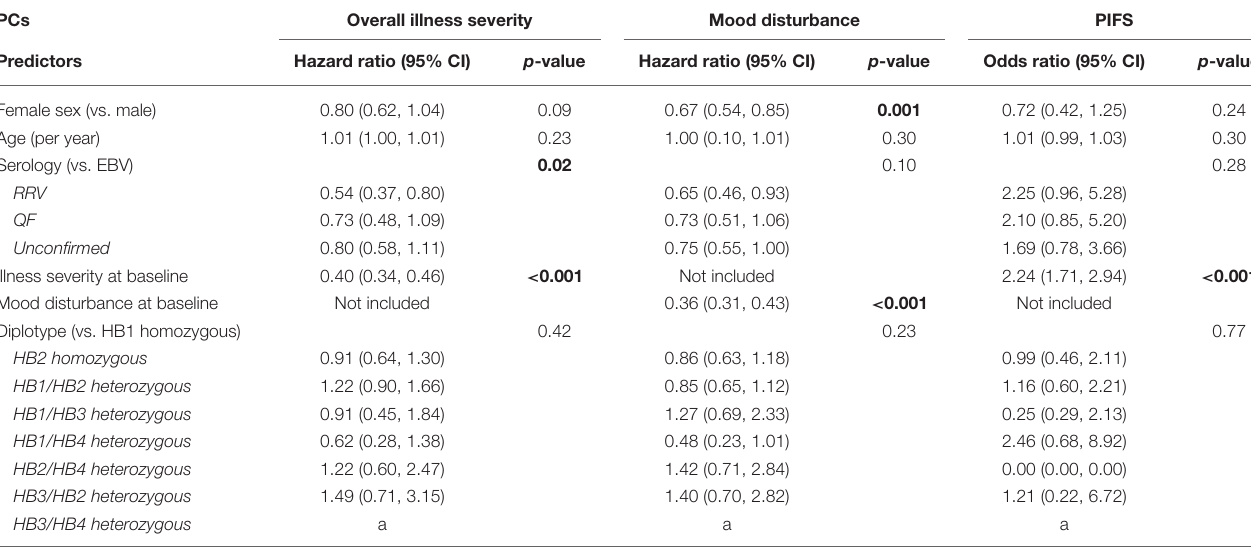
TABLE 3 | Cox-regression model for time to recovery for overall illness severity and mood disturbance